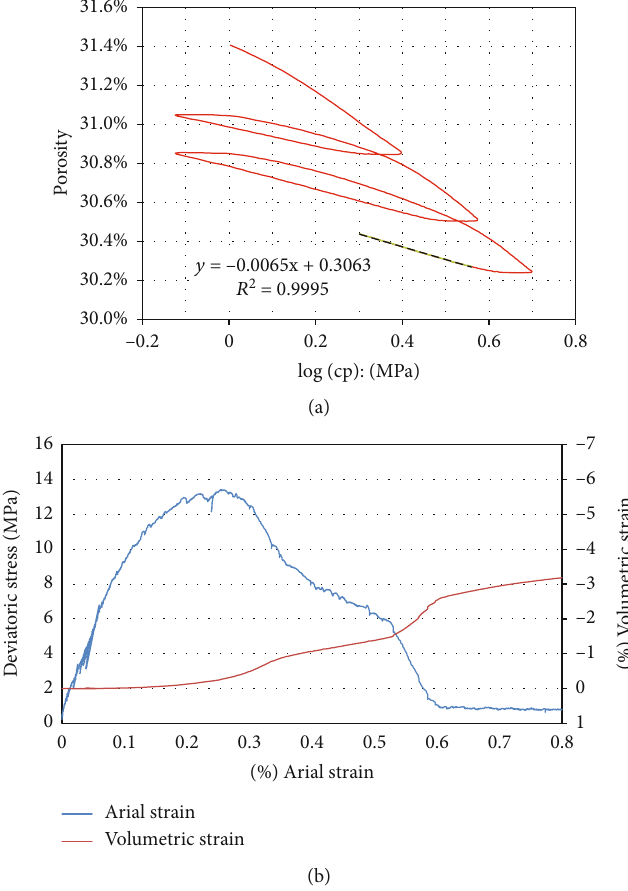
Figure 1: Triaxial test curve on sample A3 at a con fi ning pressure of 2